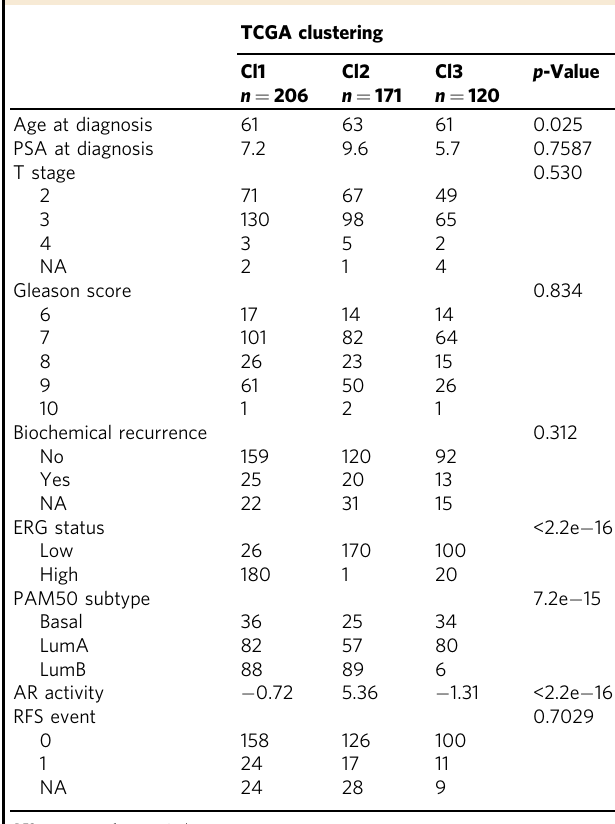
Table 3 Patient characteristics by three clusters —